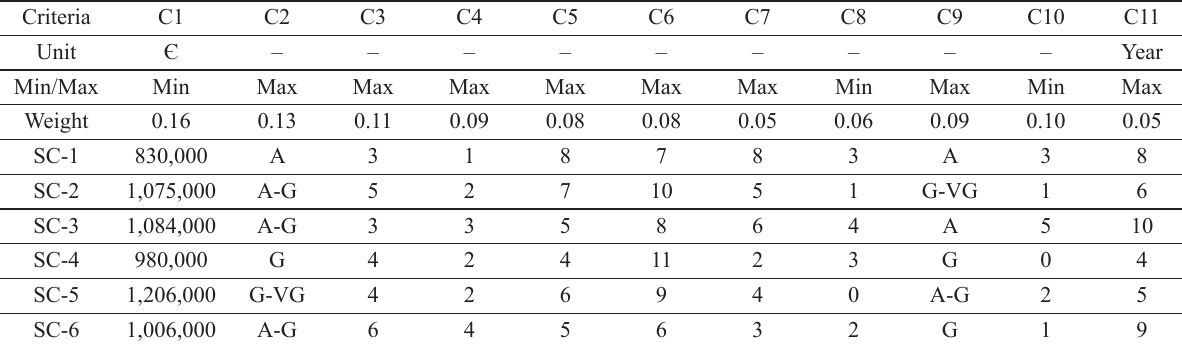
Table 4. Evaluation matrix